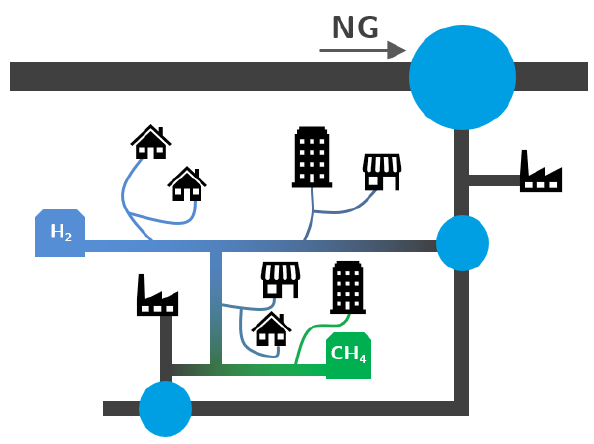
Figure 4. Schematic of a distribution gas network with distributed injection of hydrogen and